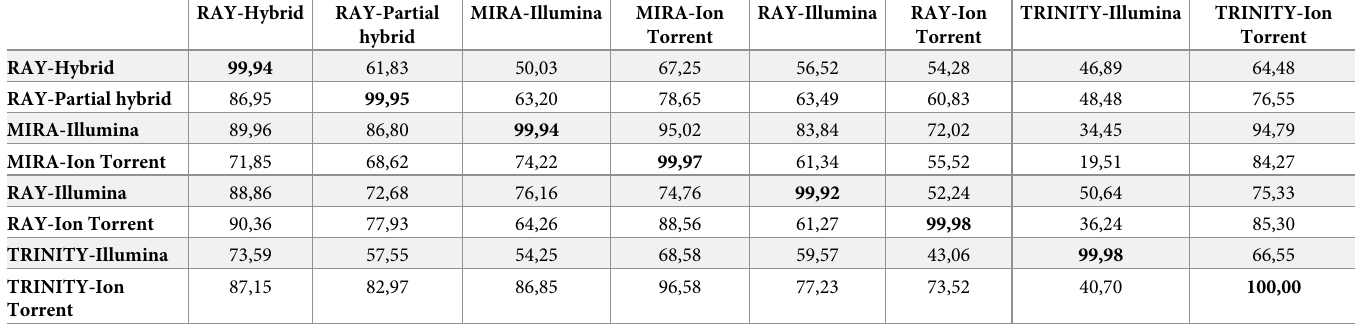
Table 2. Blast percentage matrix of all the transcriptomes built in holm oak. Each cell in the matrix represents the overlap between two assemblers-platforms.